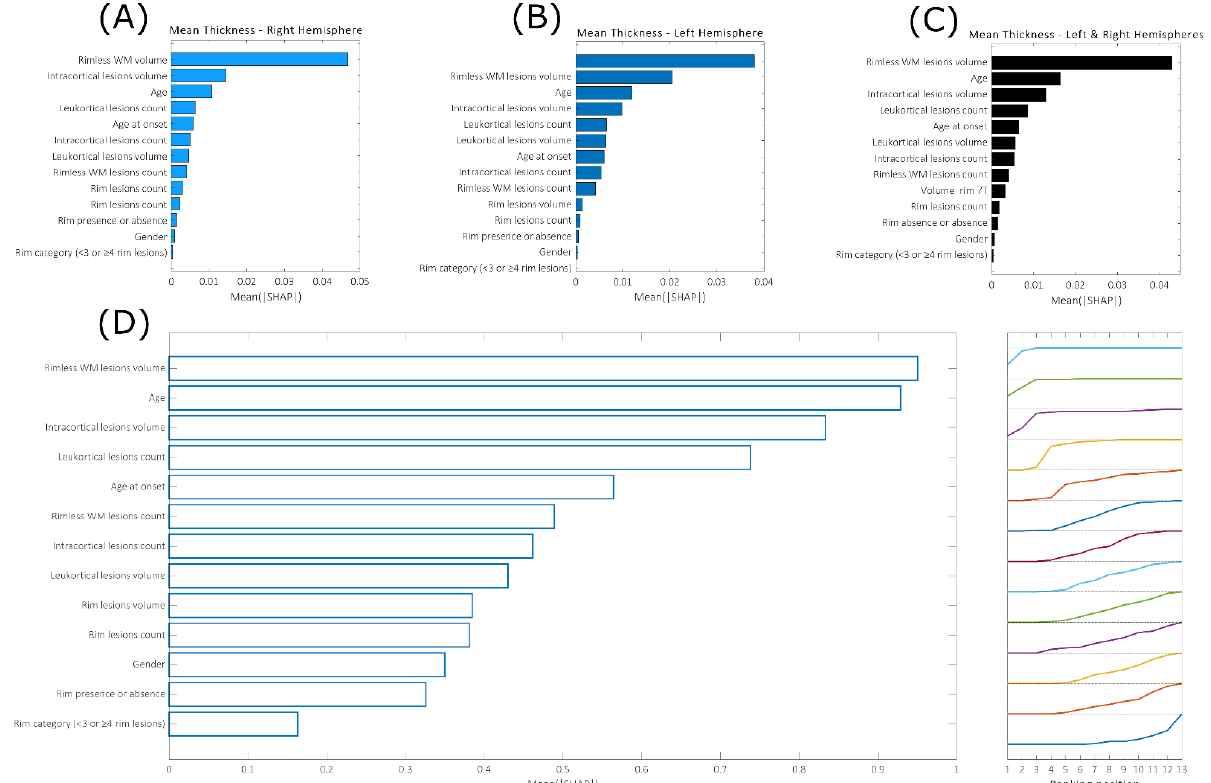
Figure 7. Mean feature importance evaluated across 50 repetitions when predicting thickness in the single hemispheres ( A , B ) and in the whole brain ( C ). ( D ): Mean feature ranking position evaluated across 36 brain regions, where the thickness values were assessed in a satisfactory manner ( p value < 0.05).